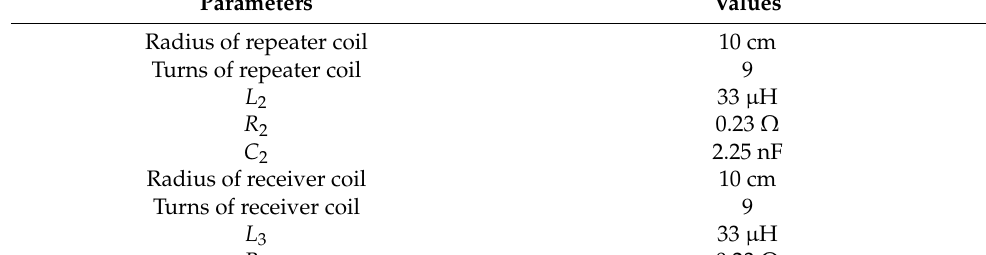
Table 1. Parameters of the repeater coil and the receiver coil.